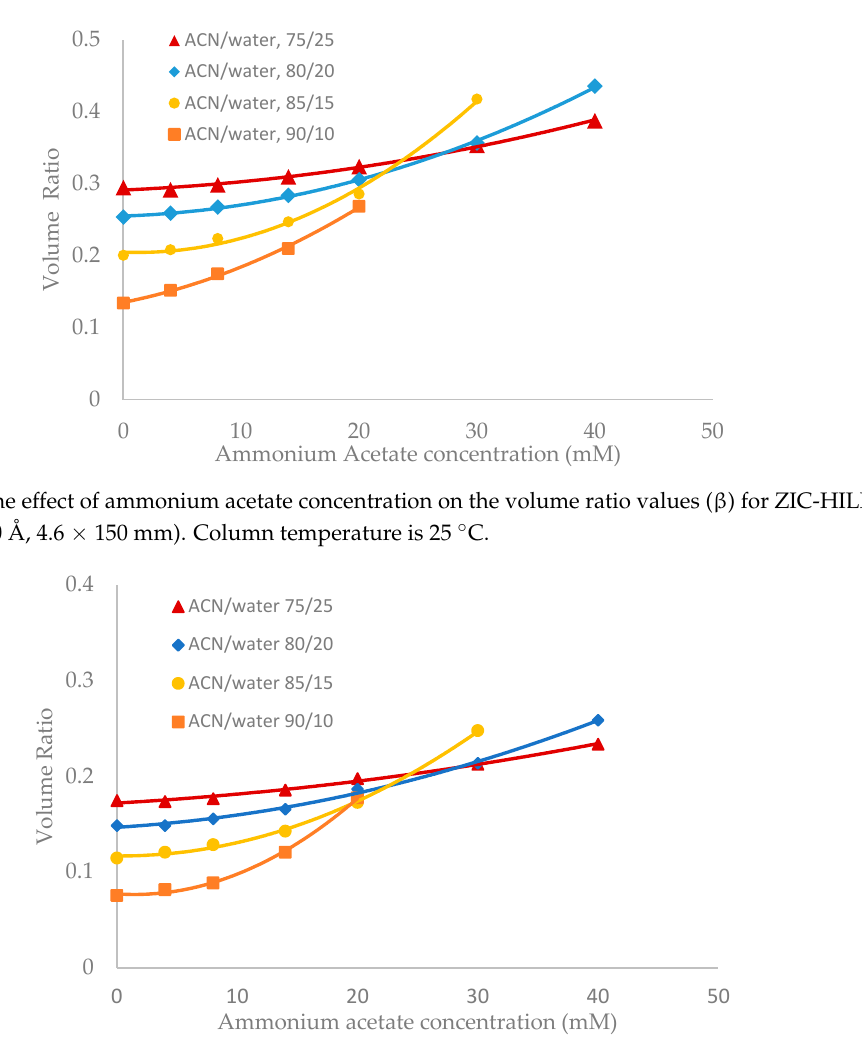
Figure 4. The effect of ammonium acetate concentration on the volume ratio values ( β ) for XBridge Amide (3.5 µm, 142 Å, 4.6 × 150 mm). Column temperature is 25 °C.